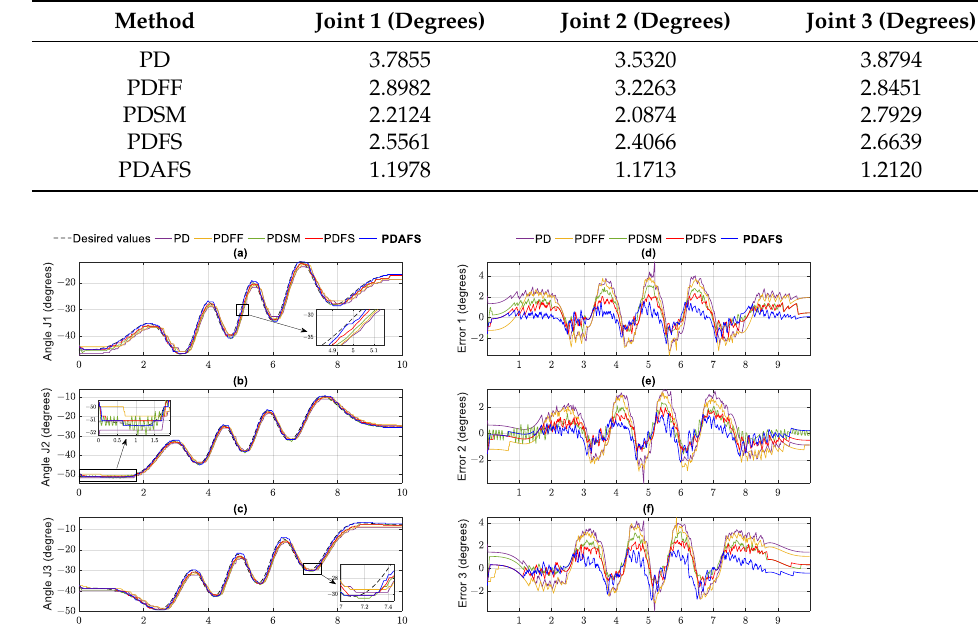
Figure 14. Tracking performance in workspace of case 1: ( a ) Helix trajectory; ( b ) parabolic trajectory.